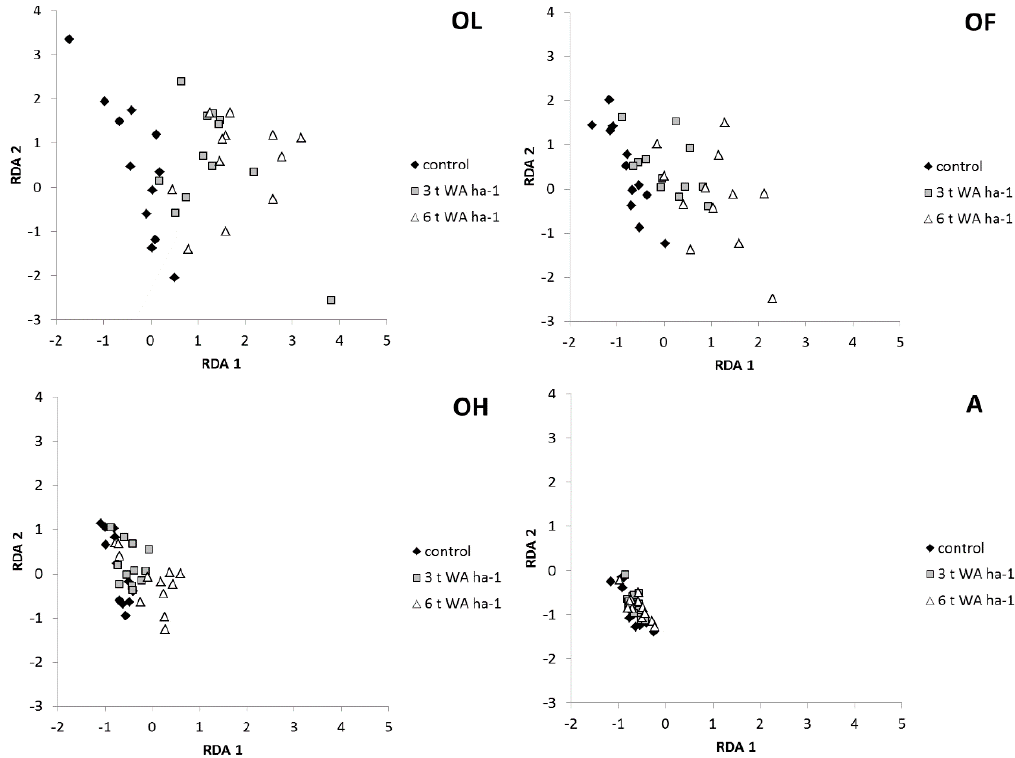
Figure 5. Redundancy analysis of soil microbial data: Sample positions.